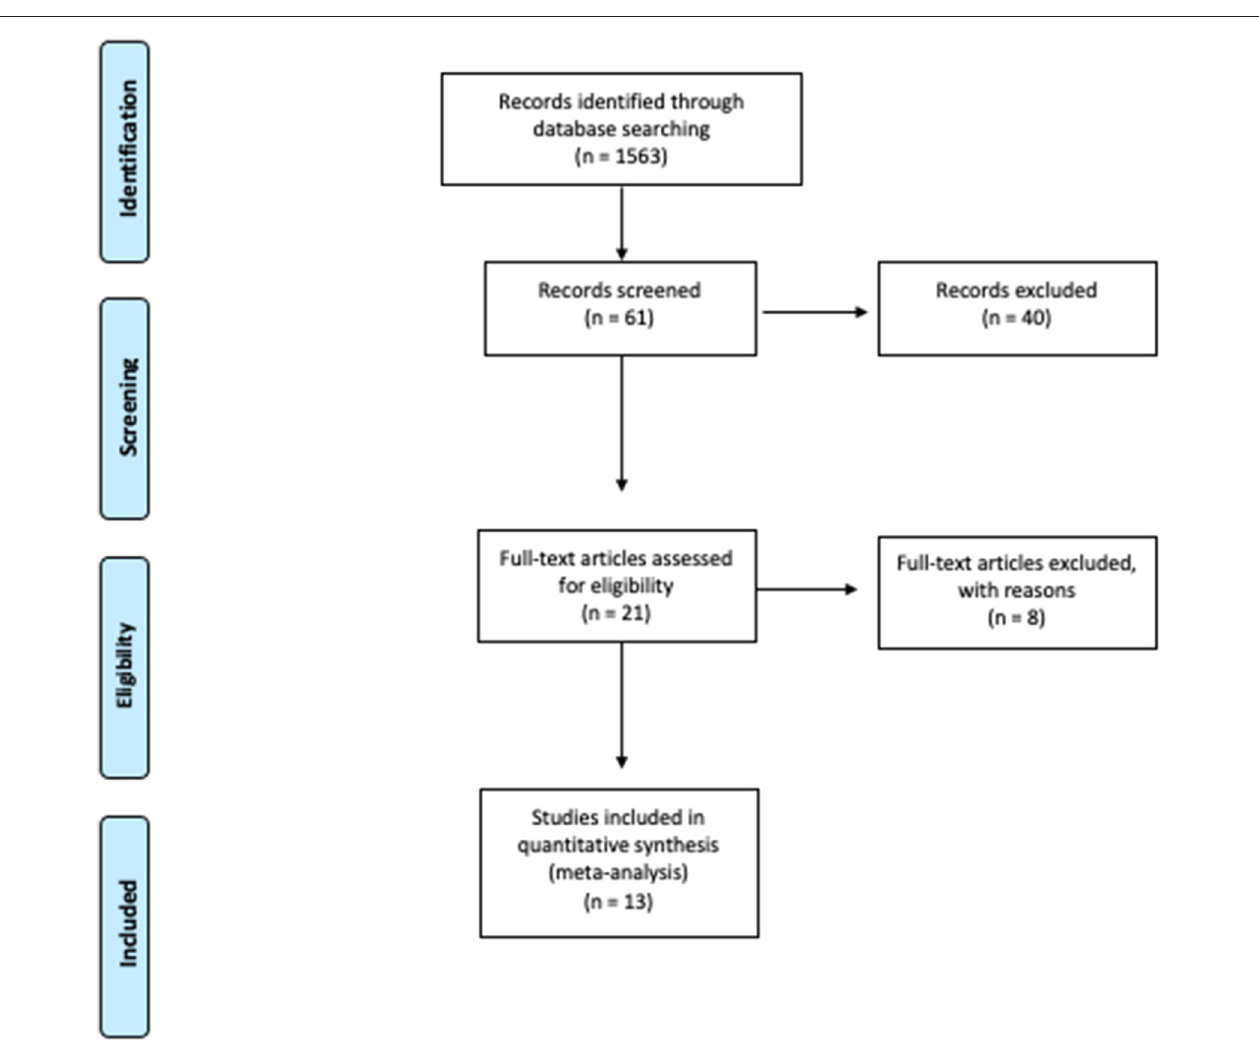
FIGURE 1 | Study flow chart (15). For more informations, available online at: